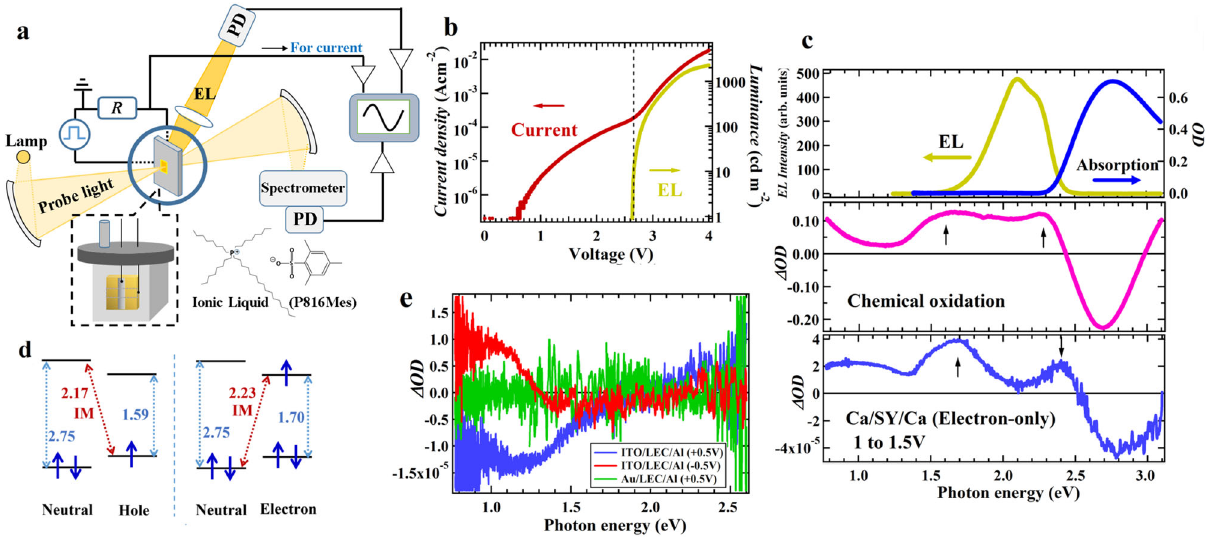
Fig. 1 | Experimental setup and the fundamental properties ofLEC used in this study.a Experimentalsetupemployedforthebias-modulation(BM)spectroscopy. A light-emitting electrochemical cell (LEC) consisting of a blend of fl uorescent semiconducting polymer, super yellow (SY) poly (para-phenylene vinylene), and ion liquid-based electrolytes (P816Mes) is driven by square wave bias and the change of absorption signal is measured with the electroluminescence (EL) inten- sityandcurrent. b Currentdensity-andluminescence-voltagecharacteristicsofthe LEC. The broken line indicates the rise energy point of EL. c The steady-state